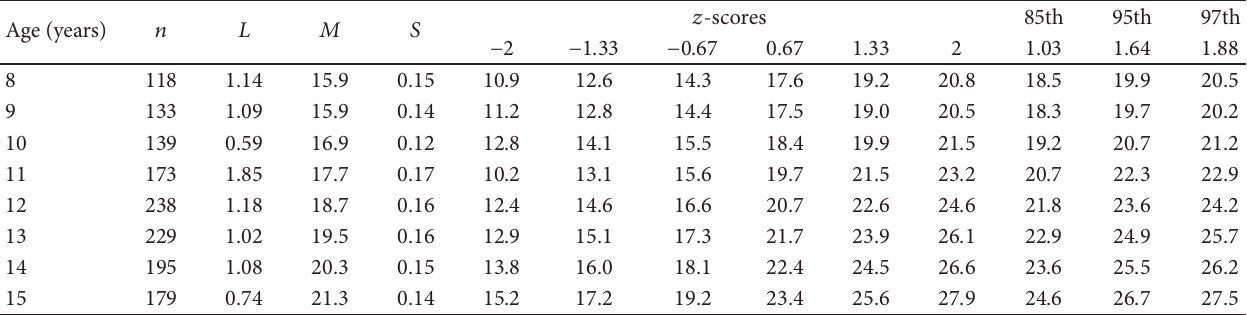
Table 3: Age specific 𝐿 , 𝑀 , 𝑆 , and 𝑧 -scores values for BMI (kg/m 2 ) from Cameroon study population using LMS method, with additional 𝑧 -scores and percentiles: Girls.